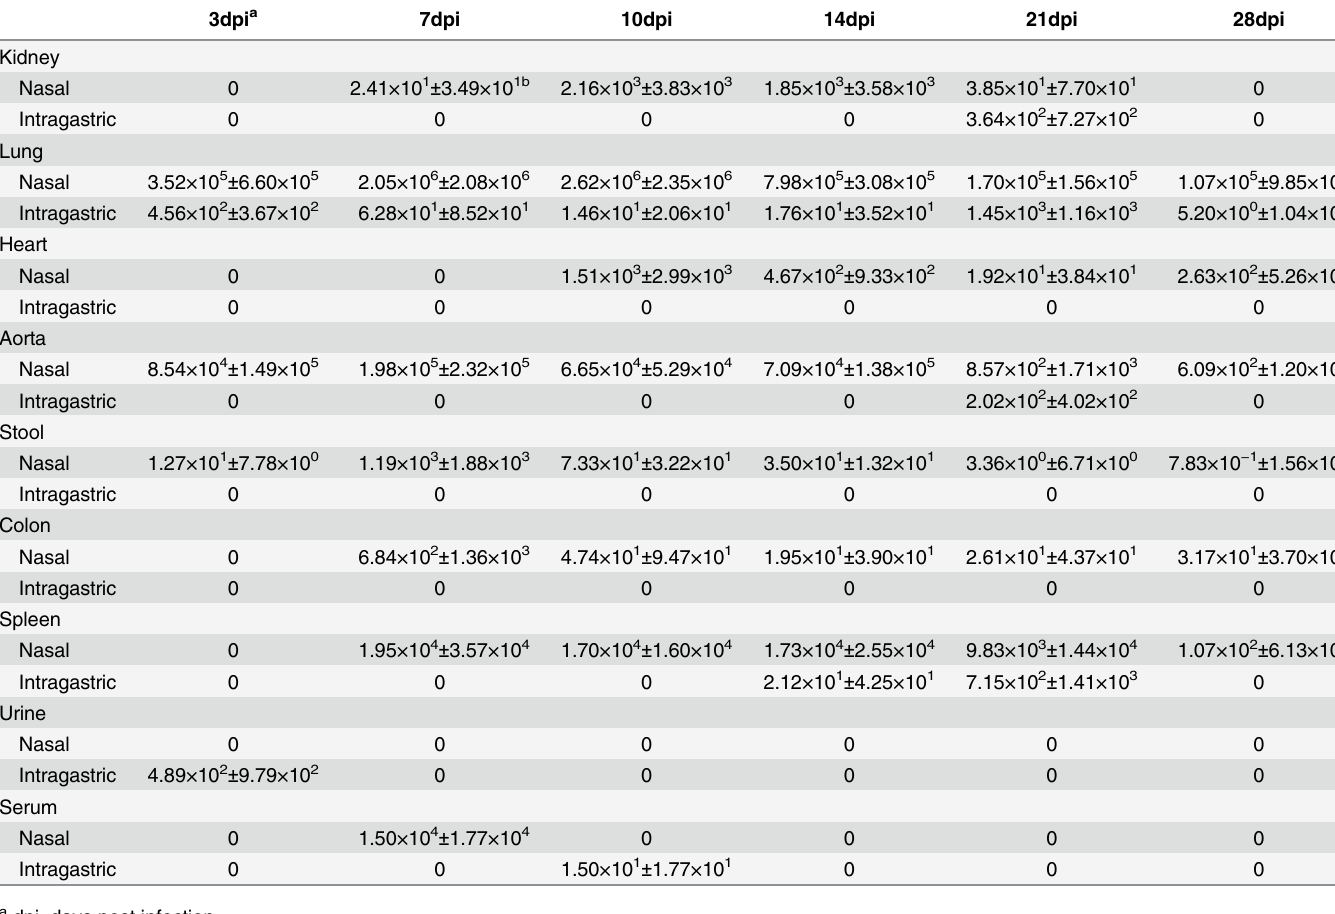
Table 1. Viral Loads Determined by Real Time Quantitative PCR after Nasal or Intragastric Infection (expressed as genomic equivalents/mg wet weight for solid organs and stool and copies/mL for body